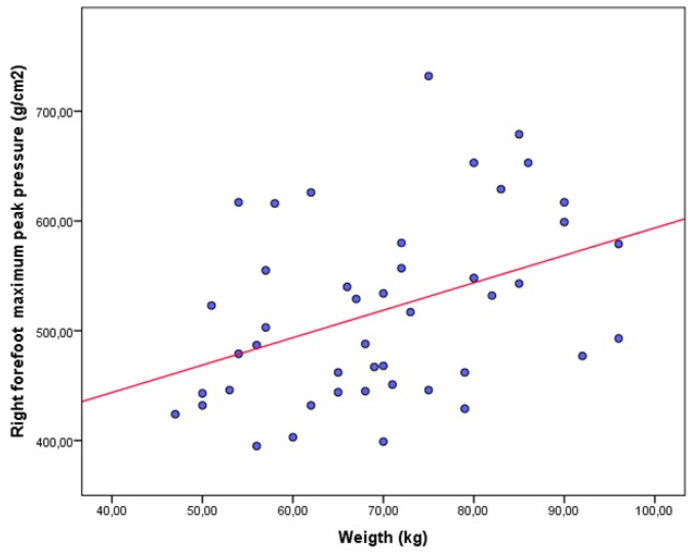
Figure 3. Scatter plot showing a significant positive weak correlation between the right forefoot maximum peak pressure and weight in healthy participants.